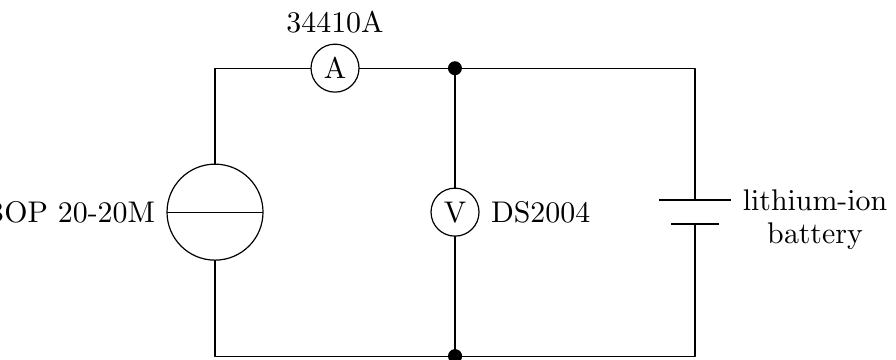
Figure 3. Schematic illustration of the measurement setup for the parameter and order identification of a lithium-ion battery model.